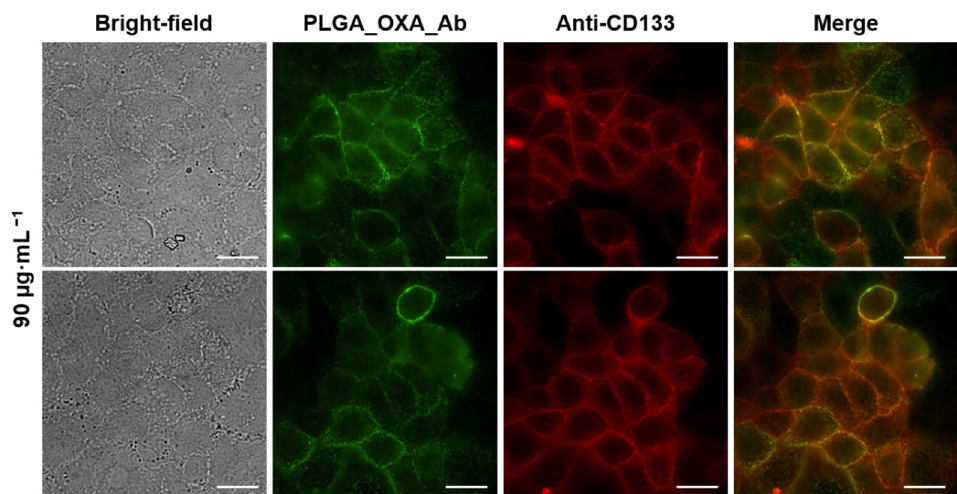
Figure 11. Fluorescence microscopy images of human cells derived from colorectal carcinoma (CaCo-2) treated with oxaliplatin-containing PLGA nanoparticles coated with anti-CD133 antibody conjugated to Alexa Fluor 488 (PLGA_OXA_Ab) and co-stained with anti-CD133 Atto 565. The CaCo-2 cells were treated with 90 µg·mL − 1 concentration of the PLGA_OXA_Ab for 30 min. From left: bright-field images of the cells; fluorescence emission of cells treated with PLGA_OXA_Ab; cells stained with anti-CD133-Atto 565; merge of the fluorescence images. The scale bars correspond to 20 µm.